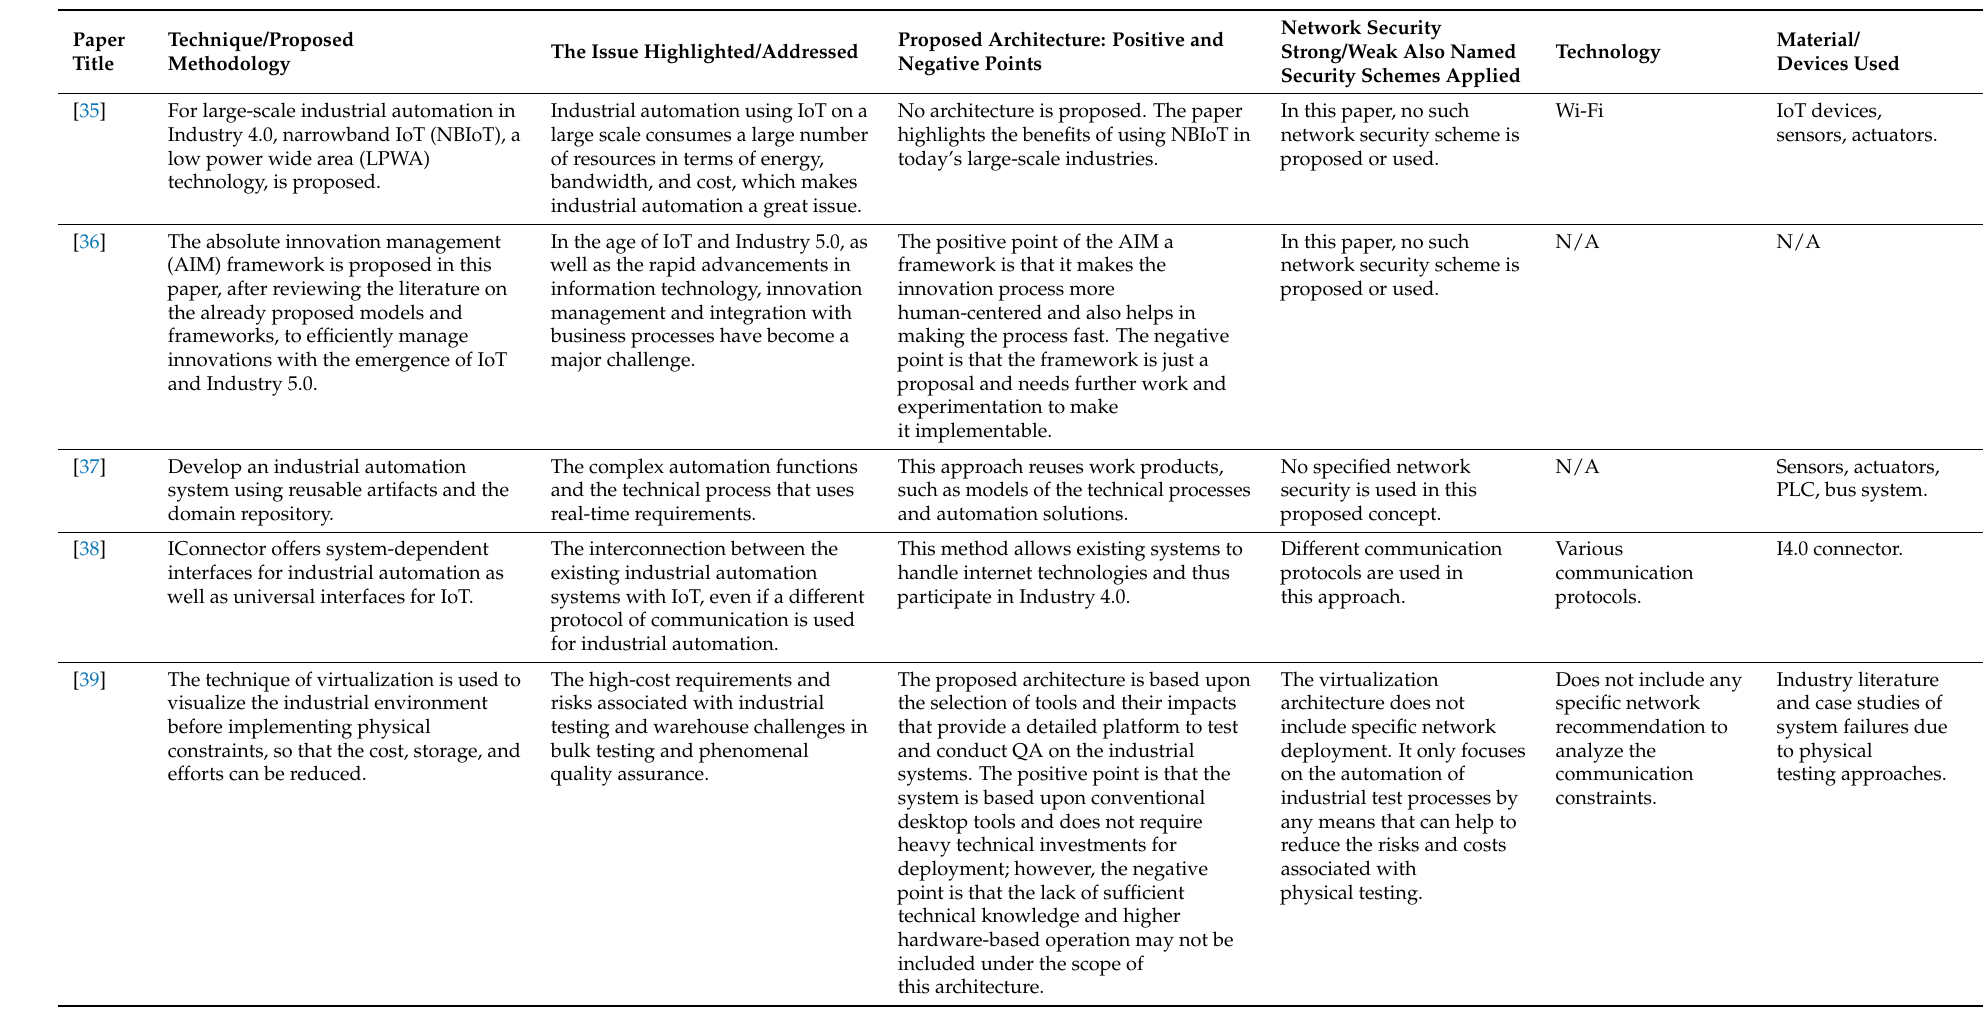
Table 2. Current work